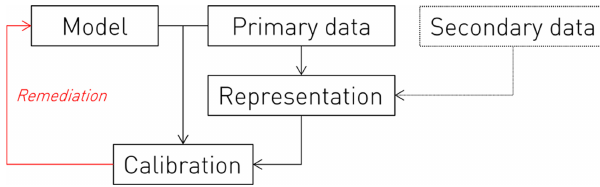
Fig. 1 The Representational Ethical Model Calibration Frame- work. The fi delity of a candidate model with respect to subpopula- tions identi fi ed by representation learning (performed on either primary or secondary data) is quanti fi ed in an ethical calibration step that informs appropriate remedial action, within an iterative process repeated until an agreed criterion of model equity is reached.